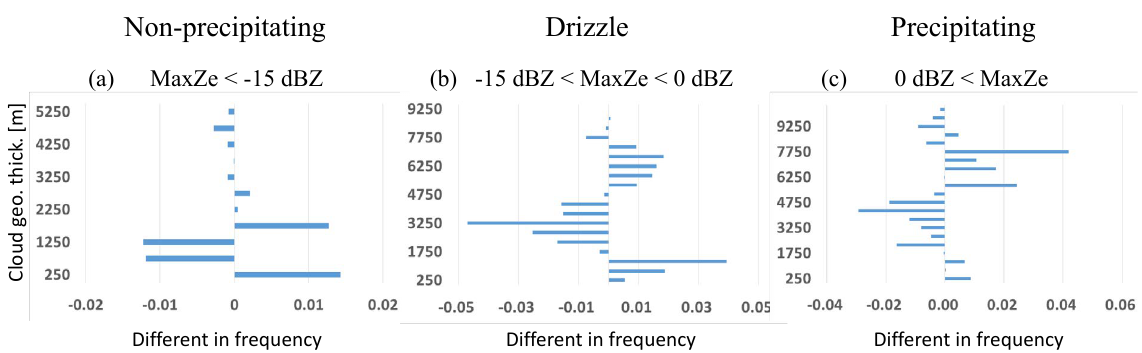
Figure 6. Difference in the frequency of the geometrical thickness (ON Kuroshio–OFF Kuroshio) according to three categories of MaxZe for (a) non-precipitating, (b) drizzle, and (c)